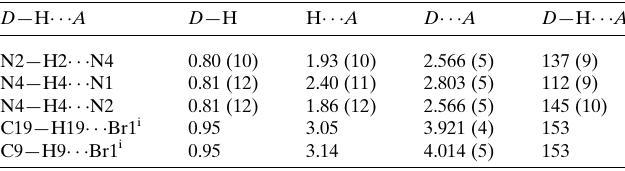
Table 1 Hydrogen-bond geometry (A˚ , (cid:3) ) for 1